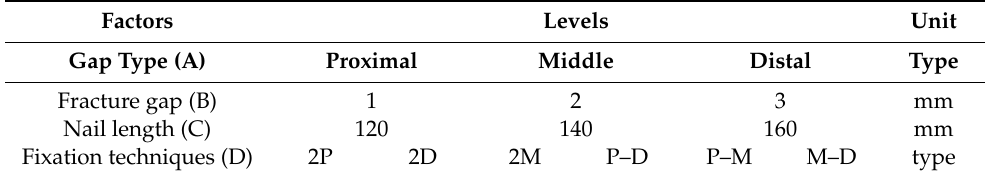
Table 3. Two locking screws: multilevel factorial design of relevant factors and their levels. (Number of levels: 3, 3, 3, and 6.).